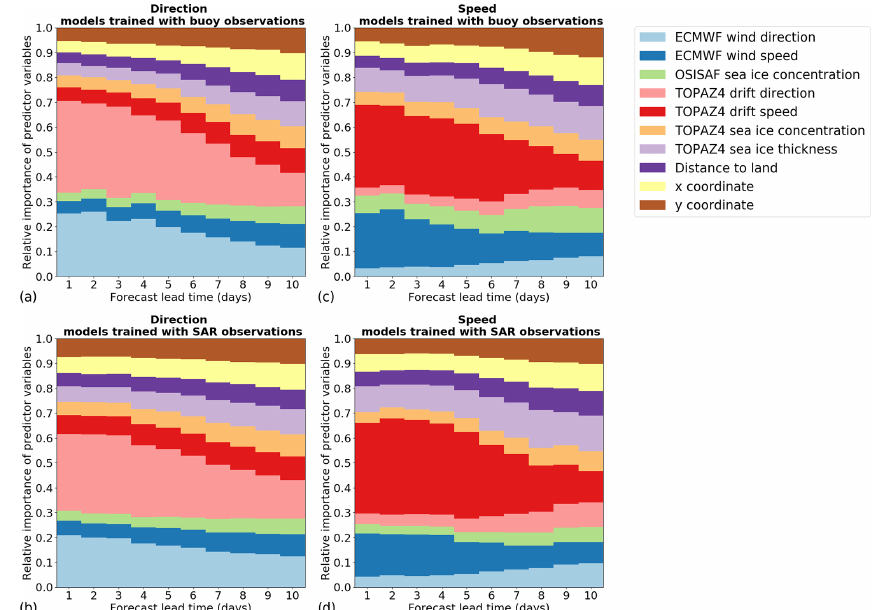
Figure 8. Relative importance of the predictor variables for the direction (a, b) and the speed (c, d) of sea ice drift assessed using the impurity-based feature importance